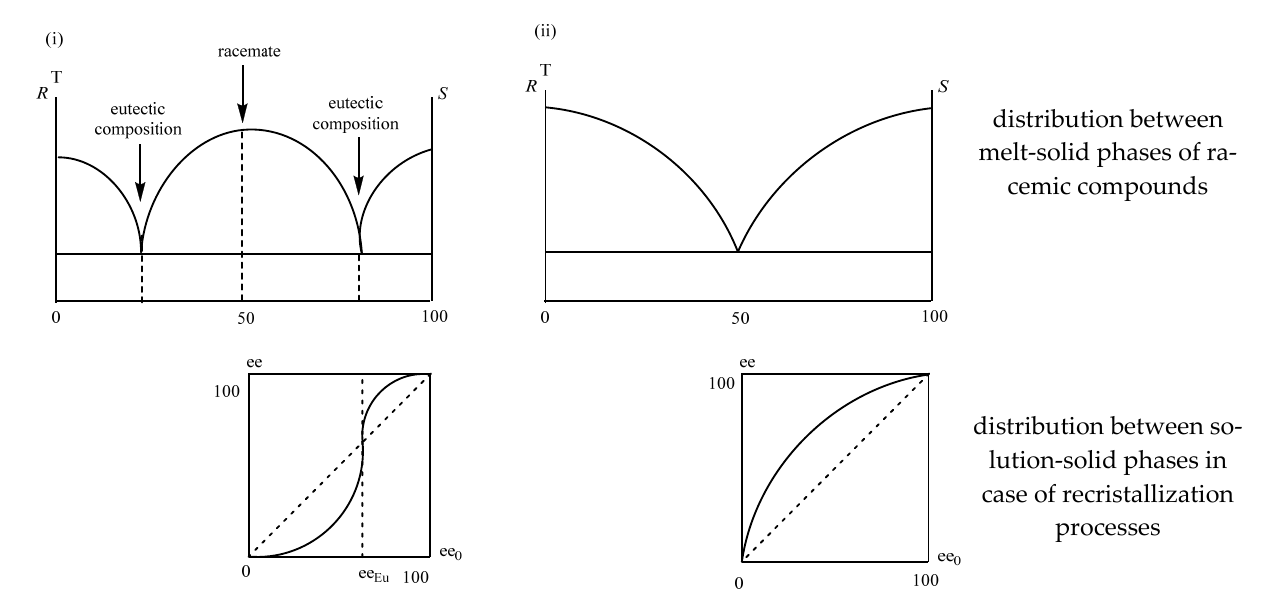
Figure 16. Distribution of racemate ( i ) and conglomerate ( ii ) enantiomeric mixtures between melt- solid and solution-solid phases.